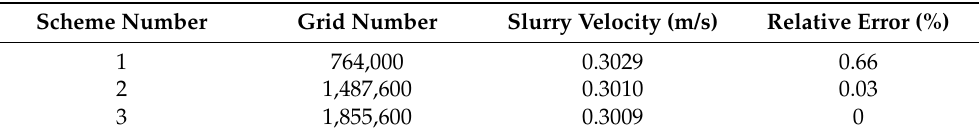
Figure 2. Grid structure of the pipe. Table 1. Slurry velocity at the S3 cross-section under different grid numbers.